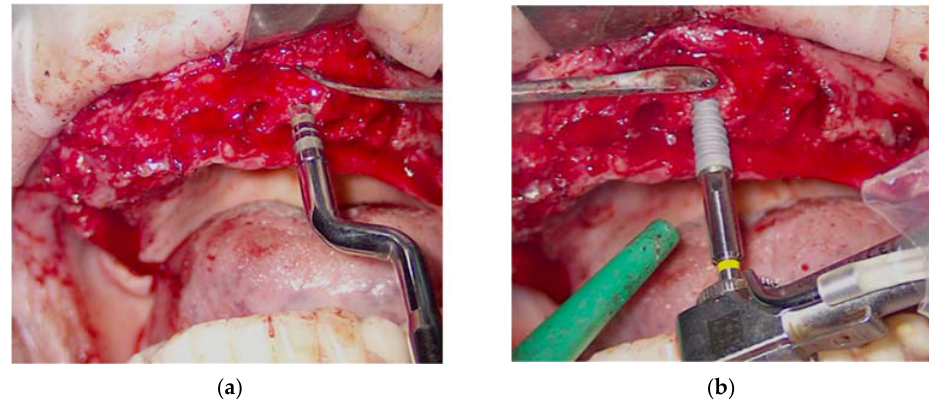
Figure 6. Use of the Magnetic Mallet to prepare the implant site ( a ); implant insertion ( b ).